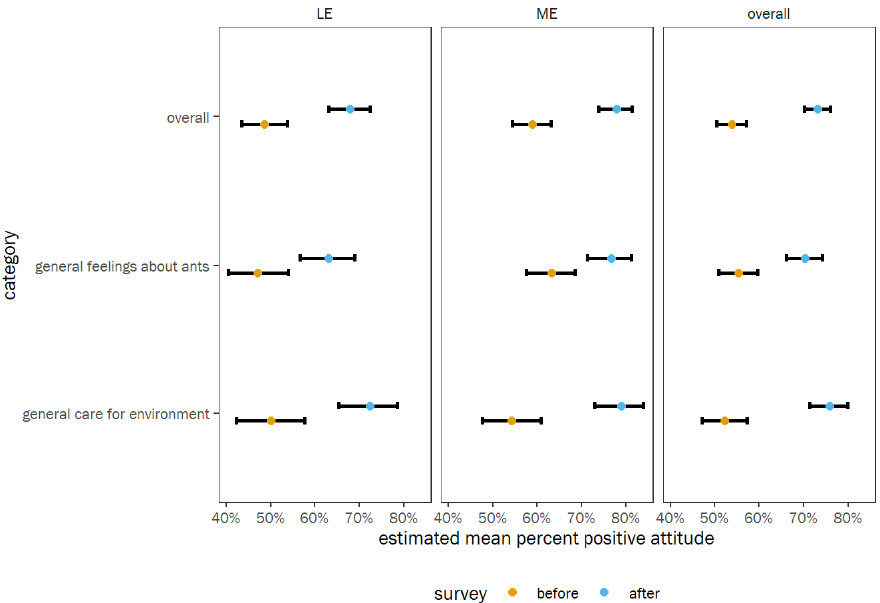
Figure 5. GLM’s estimates of percent correct scores for each category within the Attitude group at each school separately, as well as averaged across categories overall and averaged across schools overall. Points show the estimated marginal means, colored by survey (before or after), and error bars show the 95% confidence intervals of the means.